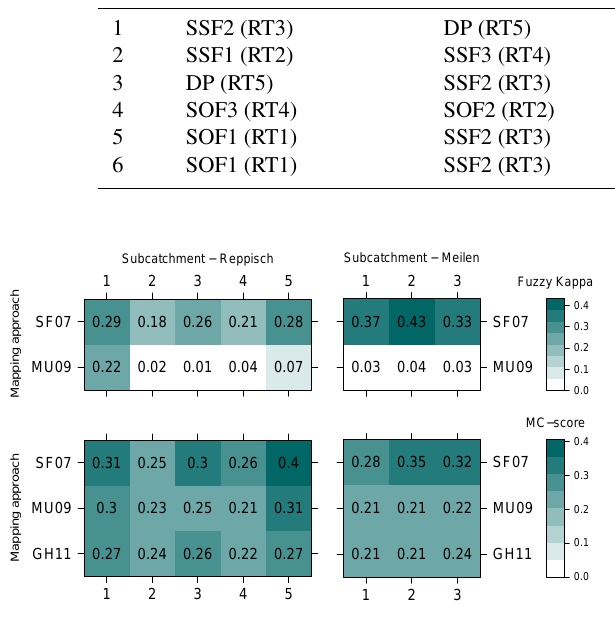
Figure 9. Agreement scores K Fuzzy and MC scores obtained by comparing the maps derived with automatic mapping approaches SN07, MU09, and GH11 with the reference (SN03) maps for the sub-catchments of the two study